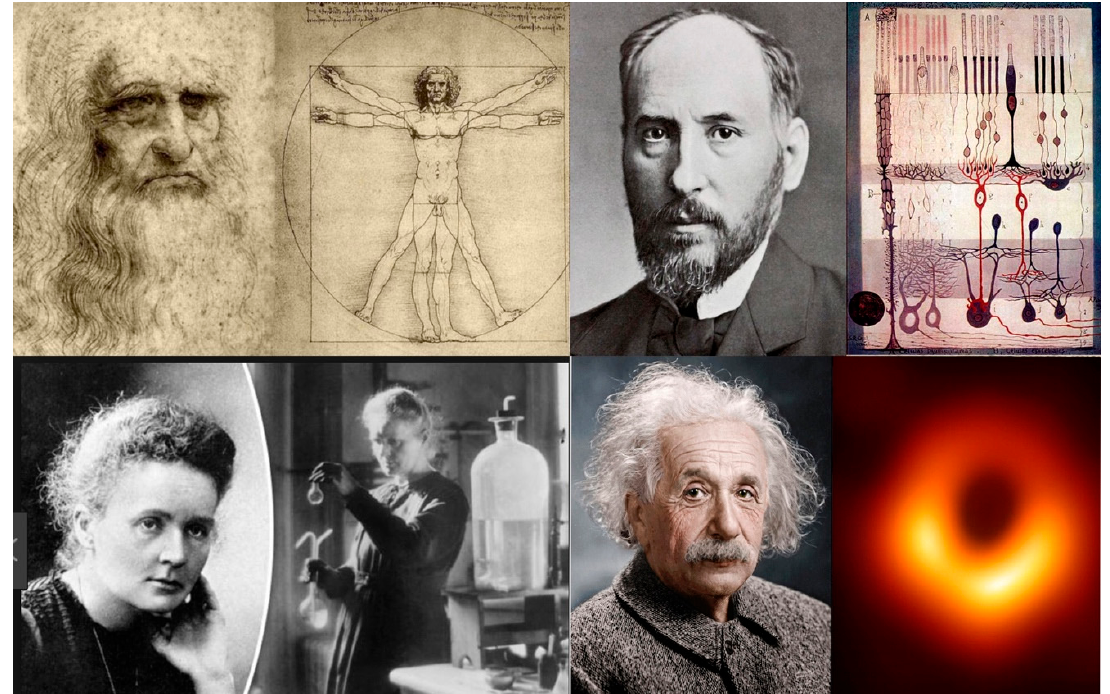
Figure 1. Michelangelo, Ramón y Cajal , Marie Curie, and Albert Einstein—creative people Figure 1. Leonardo da Vinci, Ram ó n y Cajal, Marie Curie, and Albert Einstein—creative people who used vivid mental imagery to make world-changing discoveries. Einstein’s thought experiments and his statements on the imagination are particularly